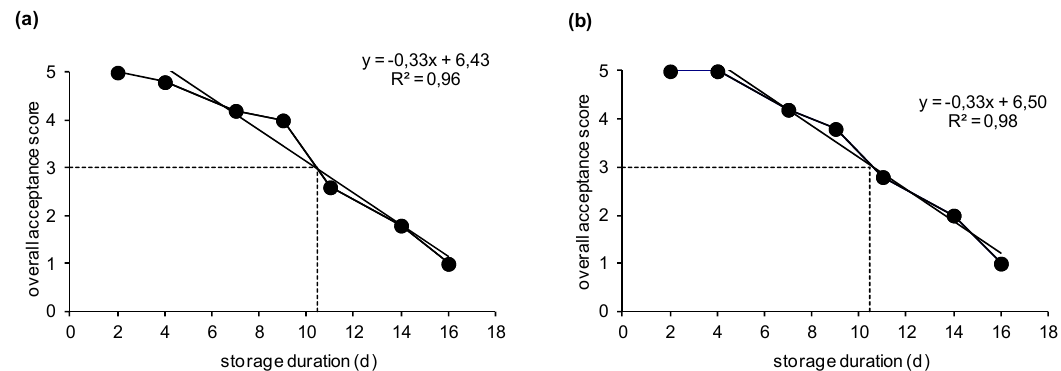
Figure 1. Overall acceptance scores of cooked ( a ) sea bass fillets and ( b ) salmon slices stored under modified atmosphere packaging (MAP) at 2 °C. Each data point is the mean score of 5 panelists. The cross-section of the dashed lines represents the point of minimum acceptability.